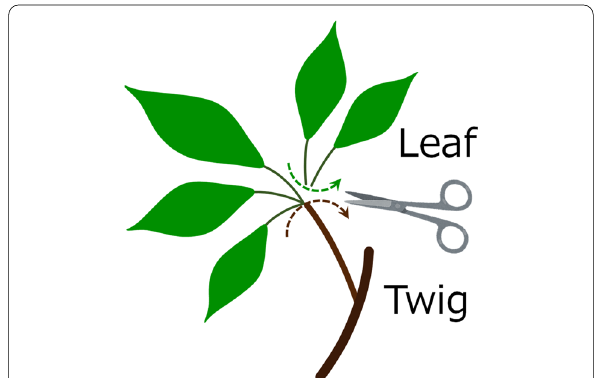
Fig. 2 Illustration of the leaf and twig separation point of the